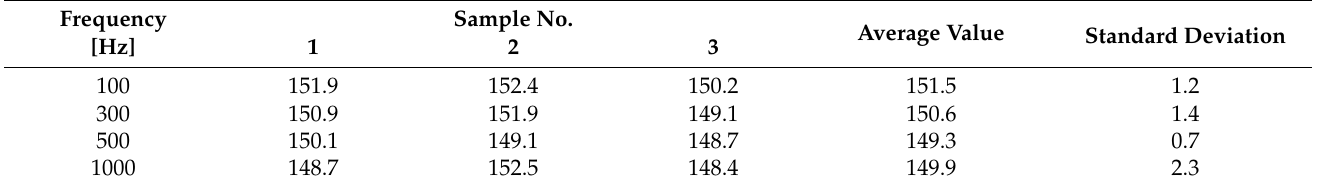
Table 6. Dynamic stiffness (dB re 1 N/m) for asphalt concrete (AC) on a concrete base course—in situ measurements (S).